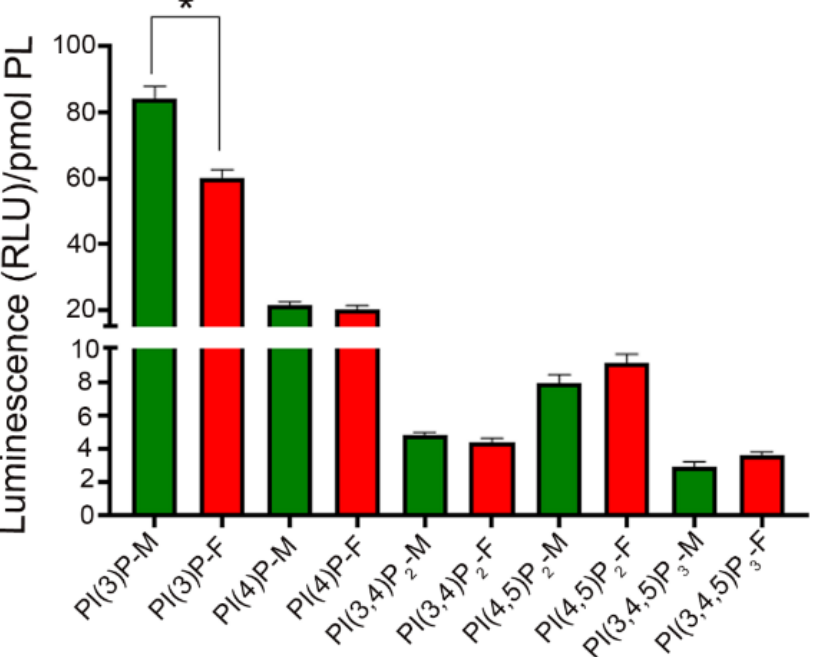
Figure 5. Determination of the levels of PIs in the mouse retina. Phosphoinositides were extracted from male (M) and female (F) Balb / c mouse retinas. The PI lipids were coated on the ELISA plate and we measured PI(3)P, PI(4)P, PI(3,4)P 2 , PI(4,5)P 2 , and PI(3,4,5)P 3 levels using PI-binding proteins as probes. Data are mean ± SEM ( n = 3). * p < 0.01, the significance of PI(3)P levels between male and female mouse retina. RLU, relative luminescence units.